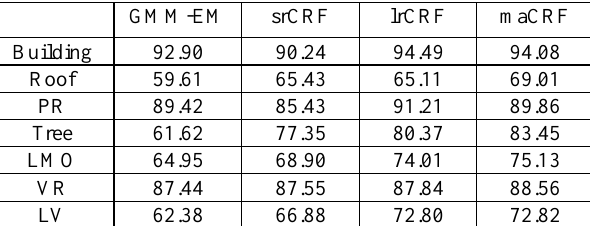
Table 4. Recall of each class in four